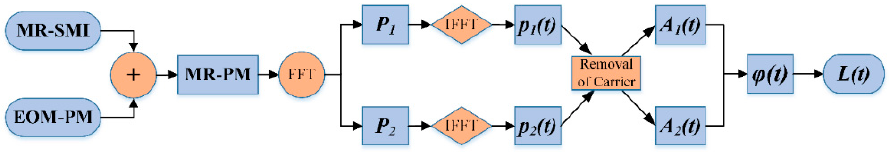
Figure 1. Flow chart of MR-PM